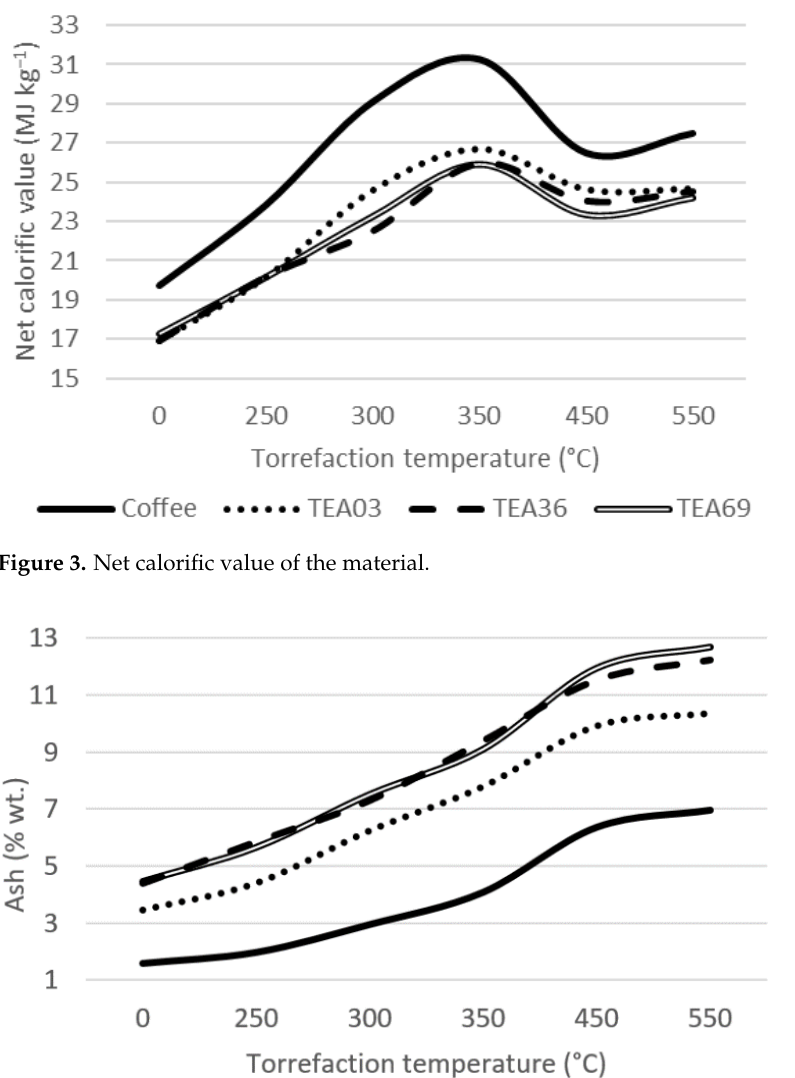
Figure 2. Carbon share of the material.